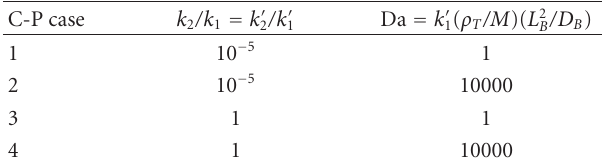
Table 6: Numerical values for simulated C-P test cases. Stoichio- metric coe ffi cients γ and (cid:2) were set to 1, representing the reaction: A + B k (cid:2) 1 −→ P , C + B k (cid:2) 2 −→ S , and the initial mass fraction of species B = 0 . 5). was always 0.5 ( w B 0